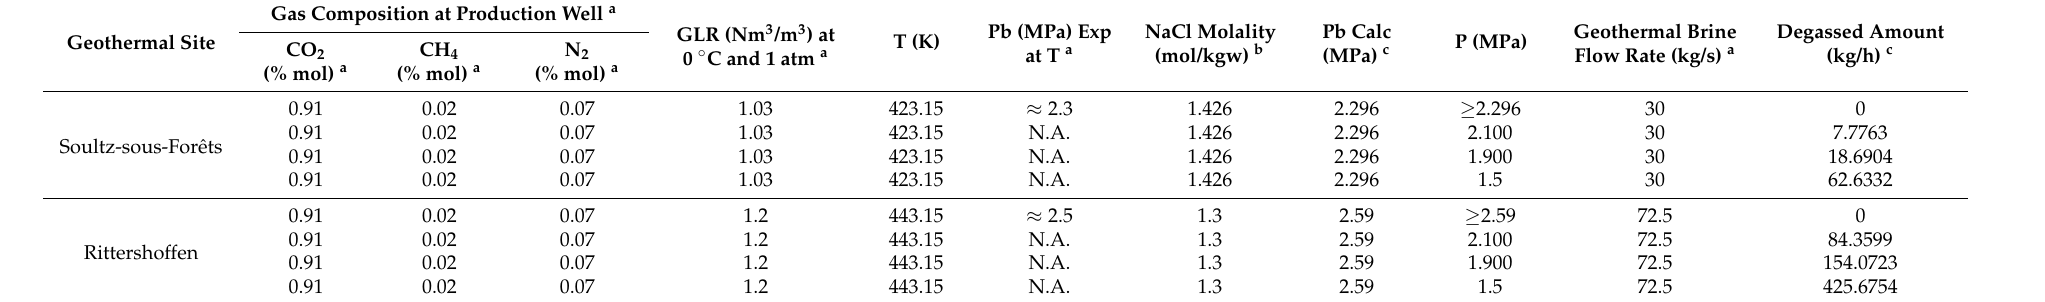
Table 5. Prediction of bubble pressures (Pb) and GHG emission rates in the Upper Rhine Graben geothermal sites.